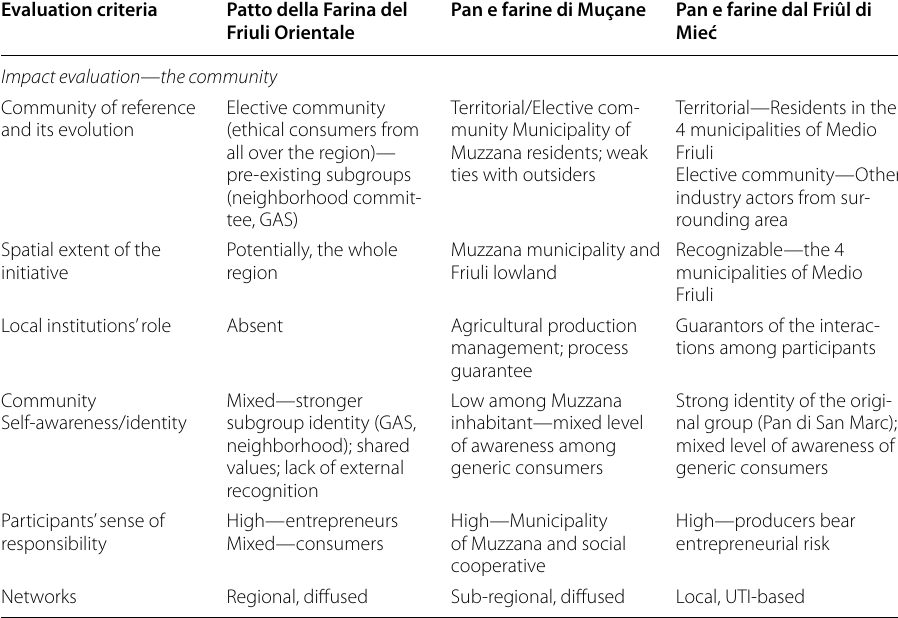
Table 3 Assessment—the role of the community Evaluation criteria